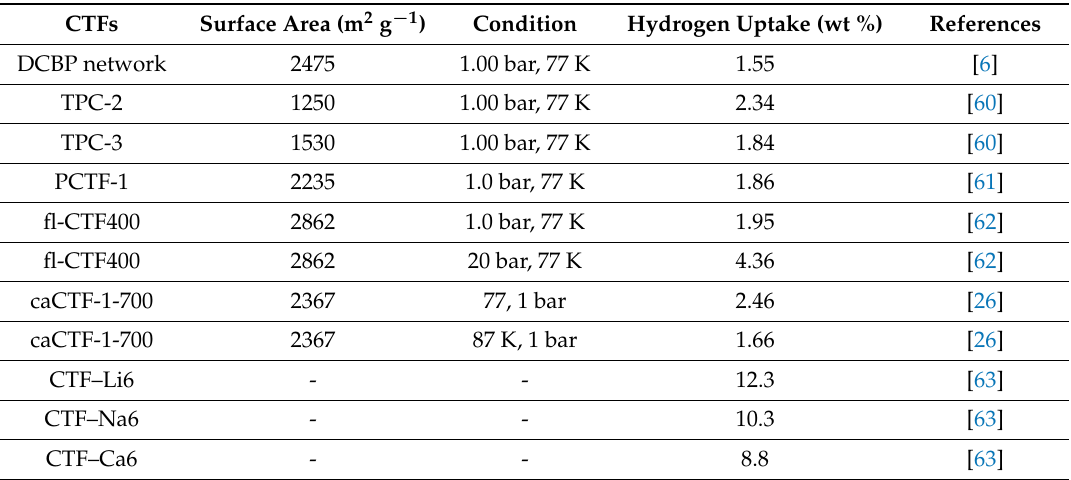
Table 1. Summary of the recent results of hydrogen uptake reported in the literature. CTFs: covalent triazine